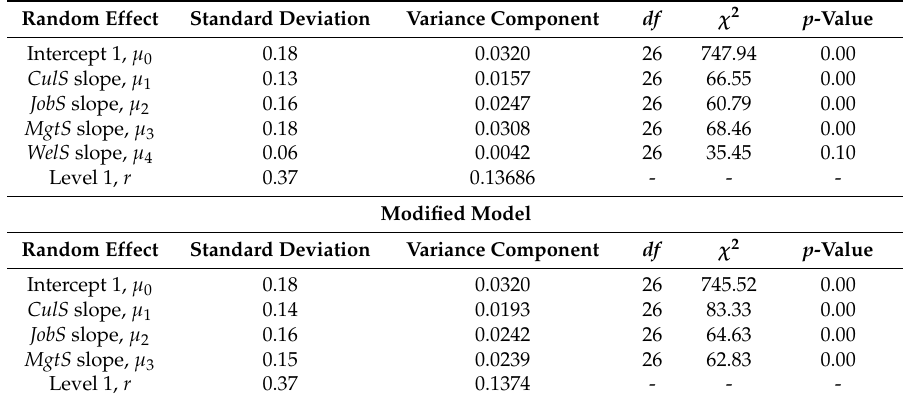
Table 2. Final estimation of variance components in the random intercept and slope